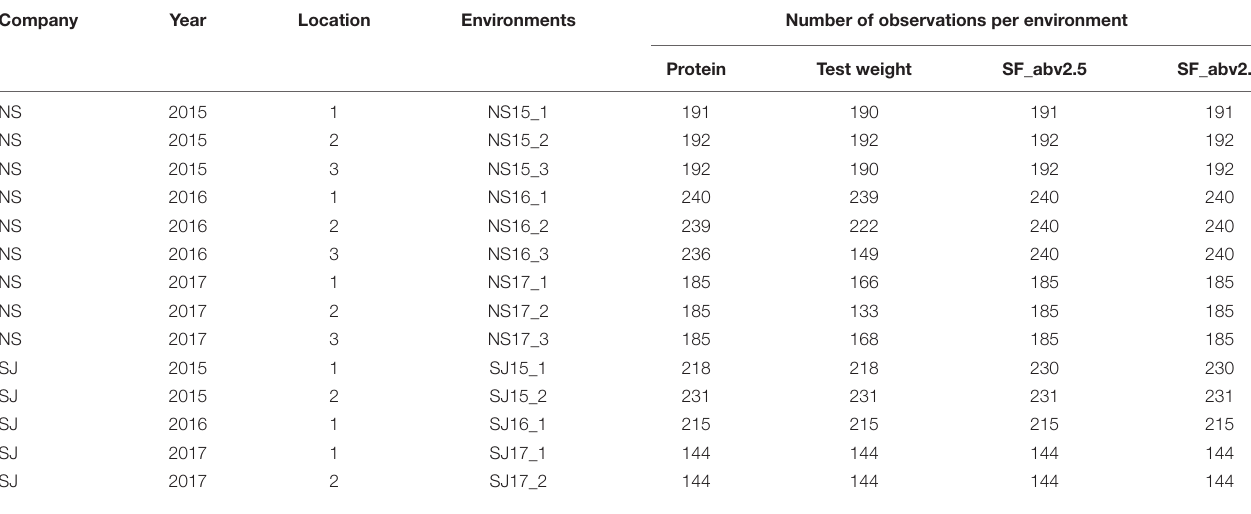
TABLE 1 | Description of environments and number of observations in each environment.